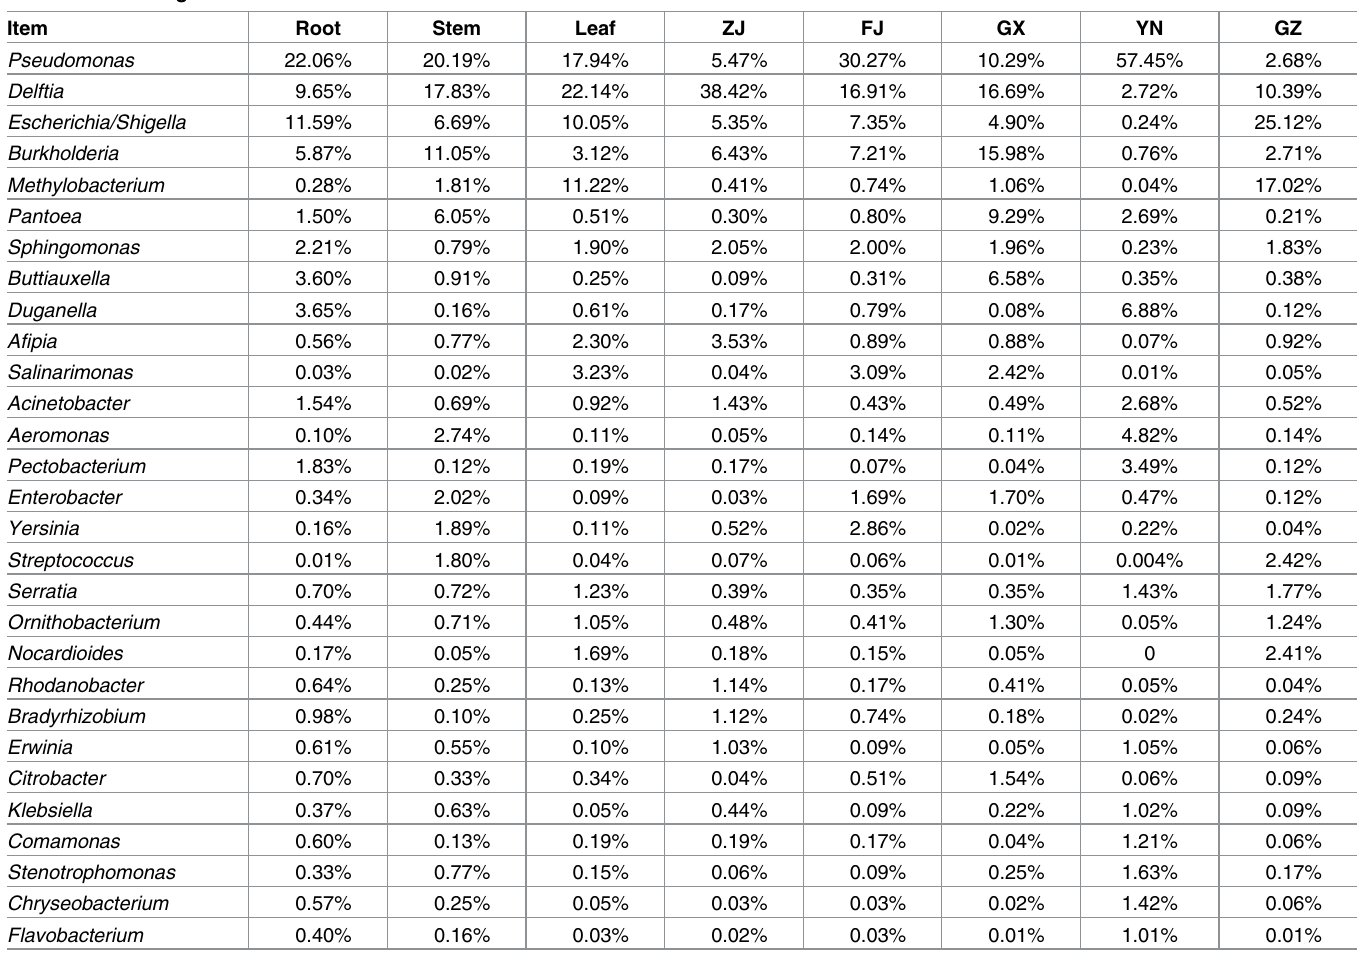
Table 3. Bacterial genera with relative abundance >